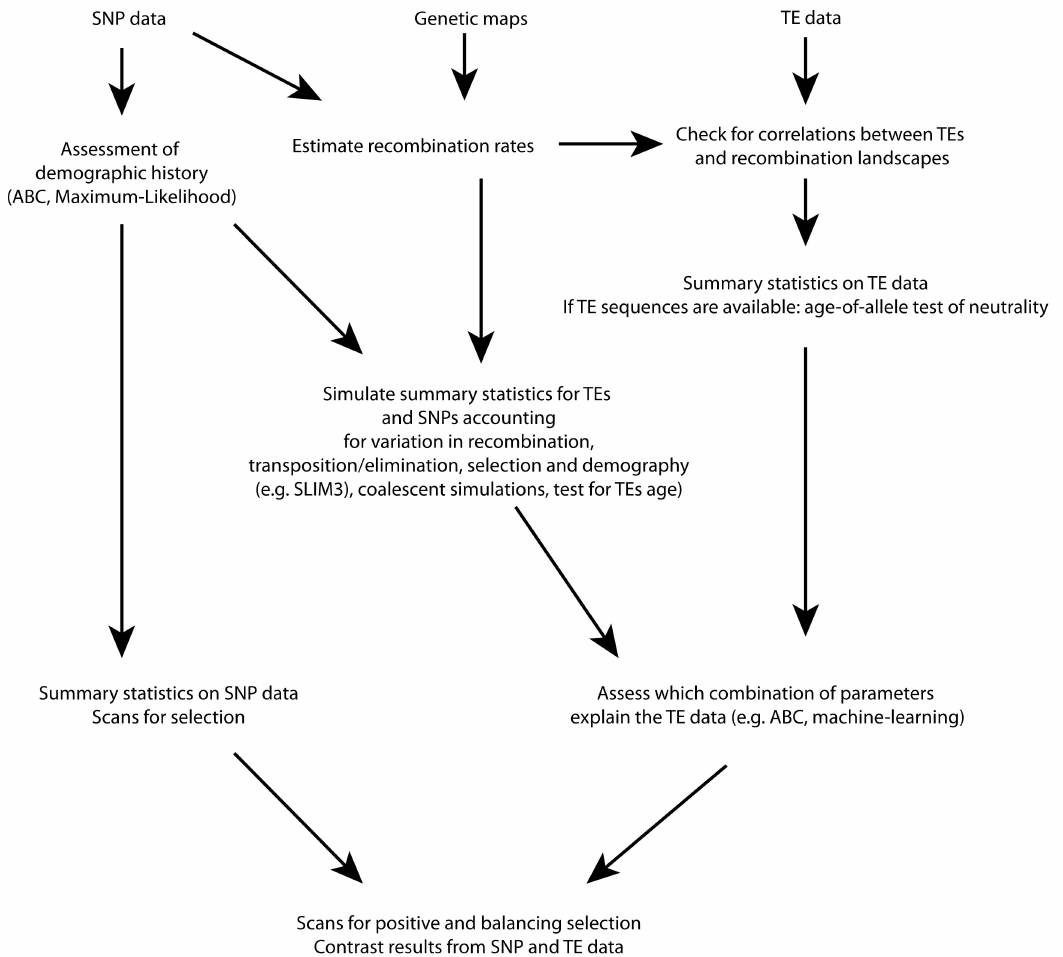
Figure 2. A possible analytical pipeline for population genomics of TEs, highlighting some promising methods. Genetics and genomics may provide information about the intrinsic properties of genomes (e.g., recombination maps) and extrinsic processes such as demographic changes and selection. This information may then be used to build neutral expectations about both TEs and SNPs. Contrasting the observed statistics for TEs (e.g., frequencies, length, properties of flanking regions) with simulations may facilitate the quantification of the mechanisms that act on their